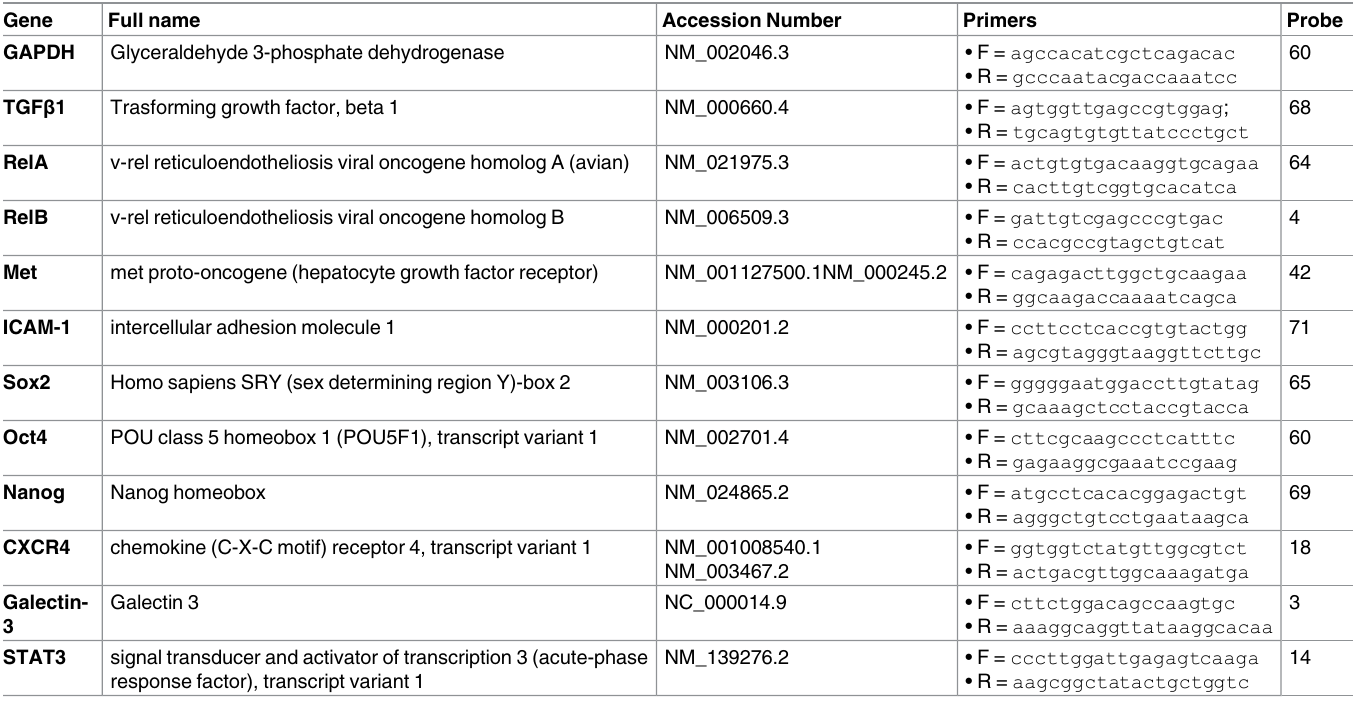
Table 1. Primers and probes. Gene symbol, name, function, accessionnumber, primer sequencesand selectedprobe are